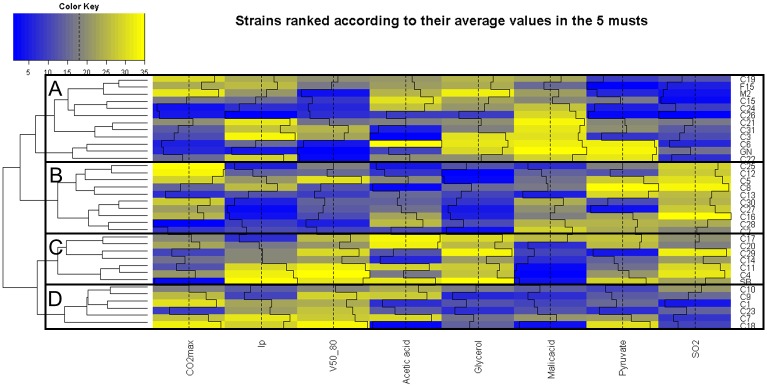
Relative ranking of 35 strains in five grape juices.Ascending order ranked of the average phenotypic values of each strain across the five grape juices. Only a subset of the representative phenotypes is represented here. A color palette shows each rank from blue (lowest ranks) to yellow (highest rank) as displayed by the color key. The rank of each cell is also displayed by a black bar plot and the vertical dashed black line represents the average rank. The dendrogram on the left represents strain ordered by hierarchical clustering.